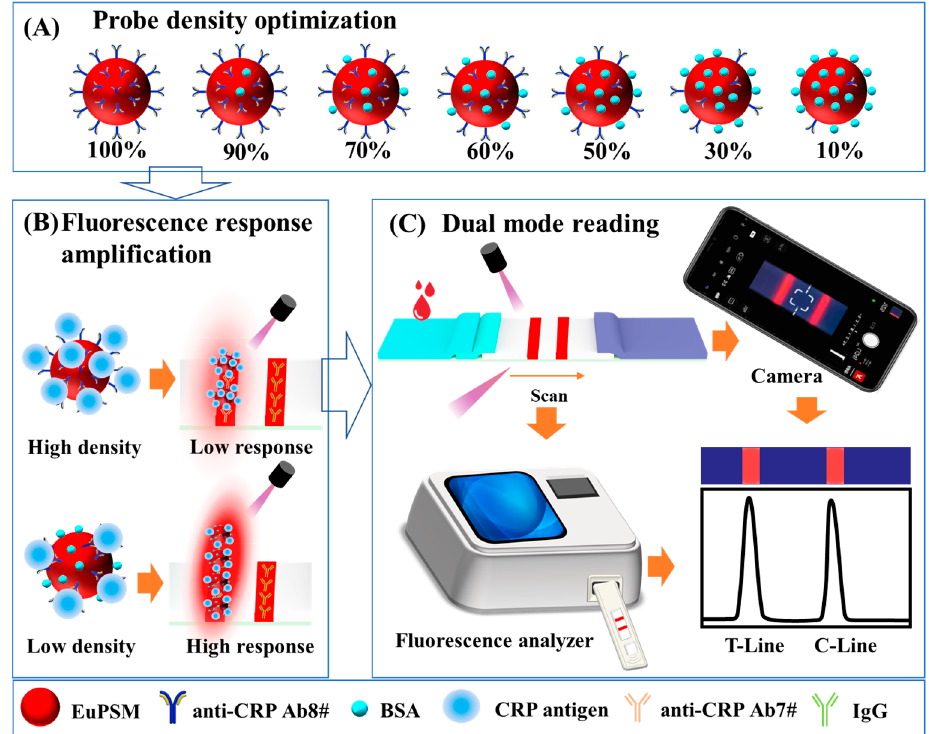
Figure 1. Schematic illustration of Eu-chelate polystyrene microsphere-based lateral flow immunoassay for highly sensitive C-reaction protein detection. ( A ) The probe density optimization on Eu-chelate polystyrene microsphere. ( B ) Schematic showing amplified fluorescence signal on lateral flow immunoassay. ( C ) The fluorescence analyzed by a smartphone and a fluorescence